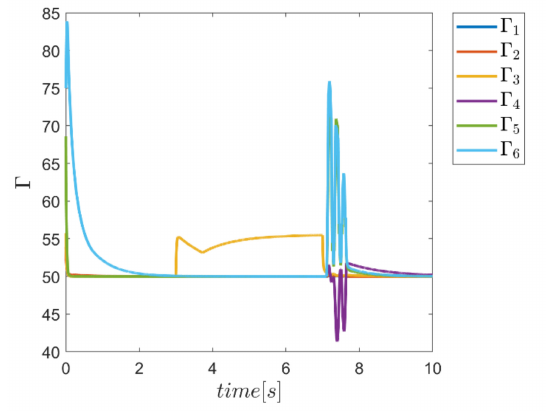
Figure 46. Adaptive variation of the coefficents of Γ for individual Γ fuzzy system.